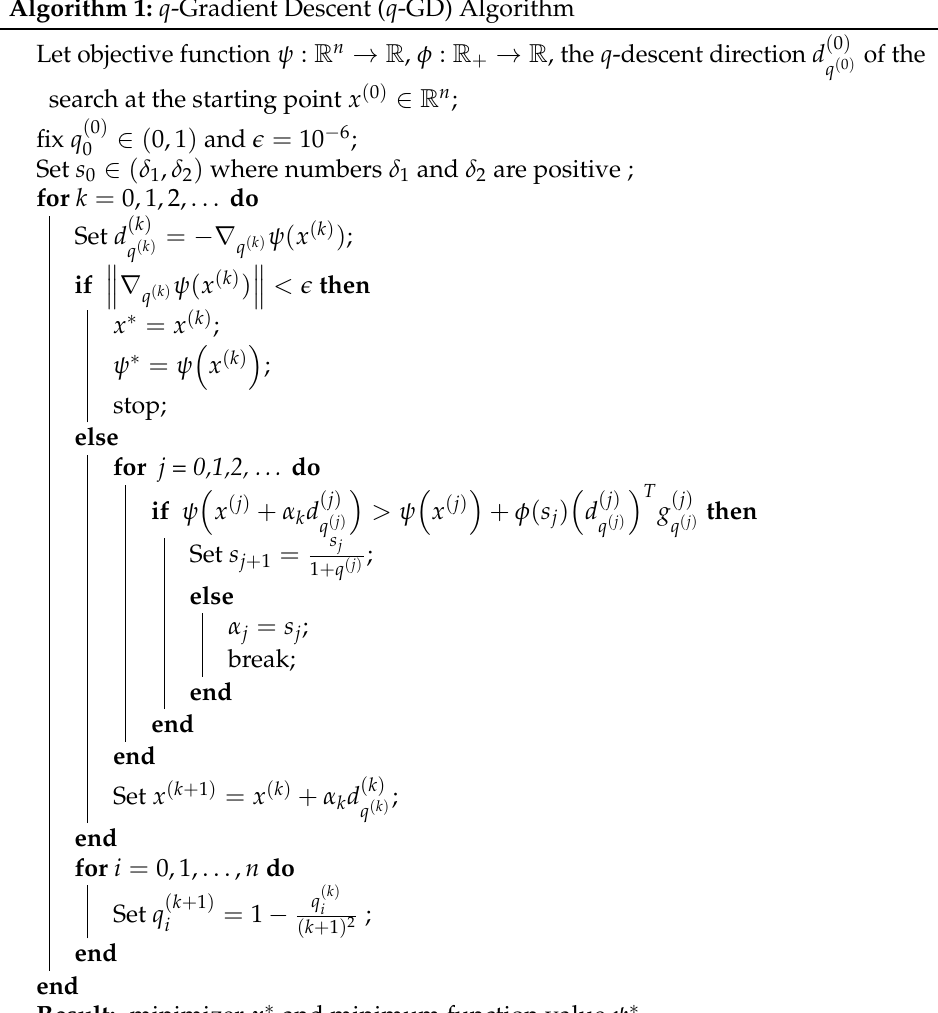
Algorithm 1: q -Gradient Descent ( q -GD)